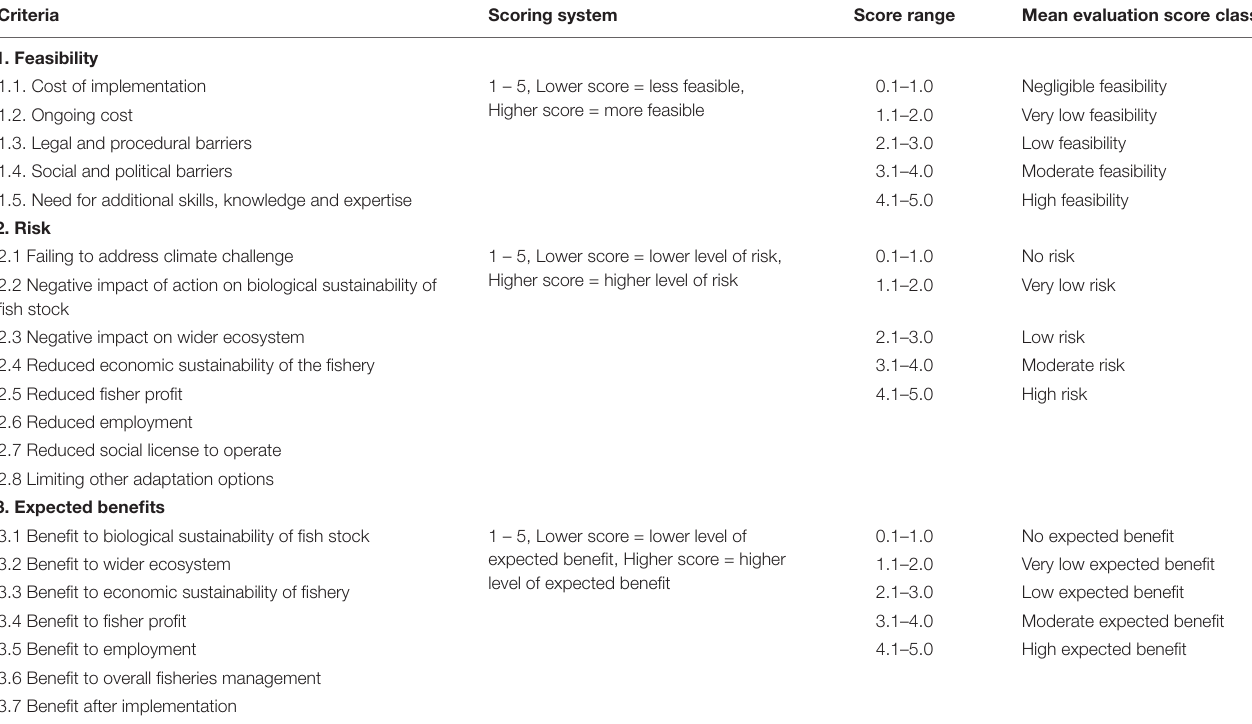
TABLE 2 | The three major evaluation criteria selected: feasibility, risk, and expected benefits.